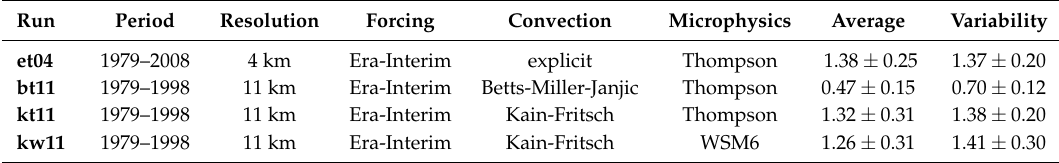
Table 1. List of WRF simulations with details of the setup. Runs with parameterized convection were performed on the EURO-CORDEX area, while run et04 was performed on a smaller domain within the EURO-CORDEX domain, with a two-way nesting strategy. The last two columns show the average number of Medicanes per year and the interannual variability with the estimated error. The annual values were computed on the “Medicane year”, from August to July of the following year. Error bars were computed with bootstrap resampling: their amplitude corresponds to one standard deviation of the distribution obtained with 10,000